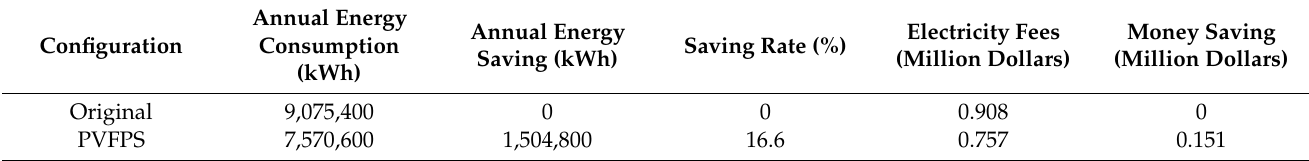
Table 4. Annual energy consumption and estimated annual electricity savings of the pumping